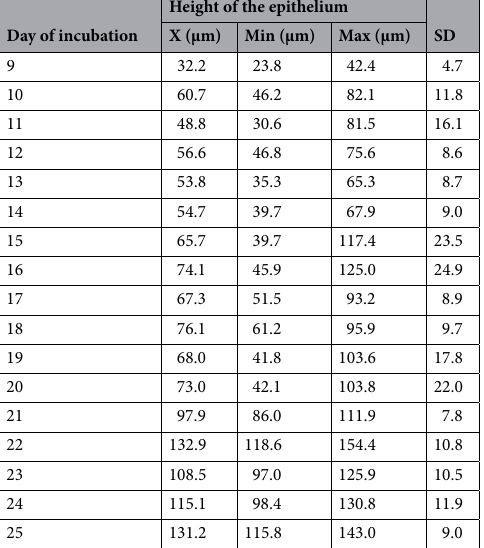
Table 1. Results of measurements of the mean height of the epithelium of the lingual prominence in the domestic goose during embryonic development. X-mean value, min-minimum value, max-maximum value, SD-standard